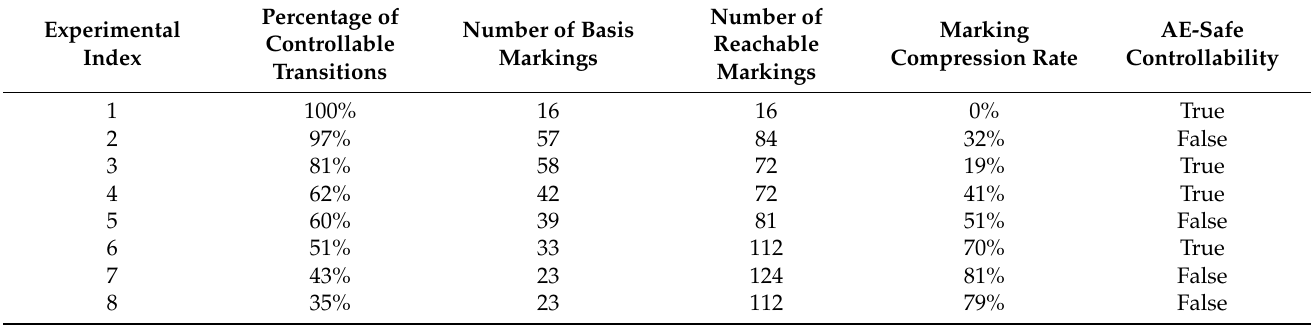
Table 1. Experimental comparison of the basis attack model and the traditional attack model